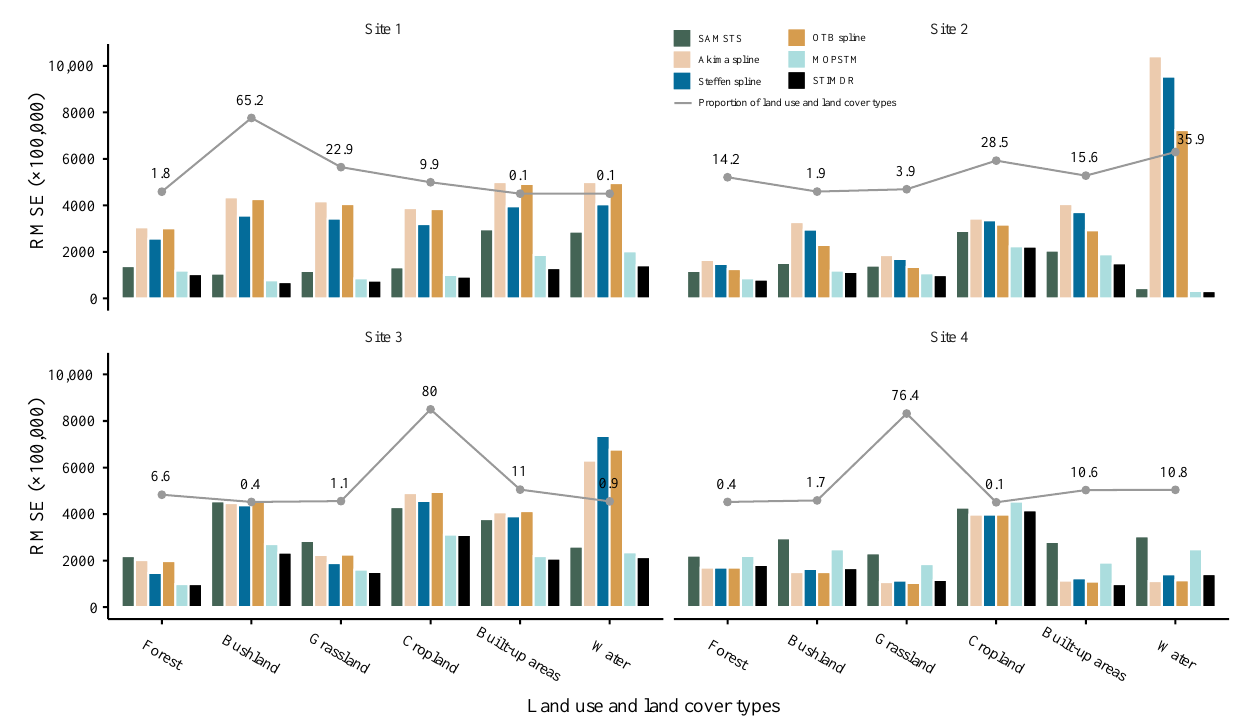
Figure 10. RMSE for different land use and land cover (LULC) types in four sites. The grey line is the proportion of the land use and land cover types in each site. RMSE was multiplied by